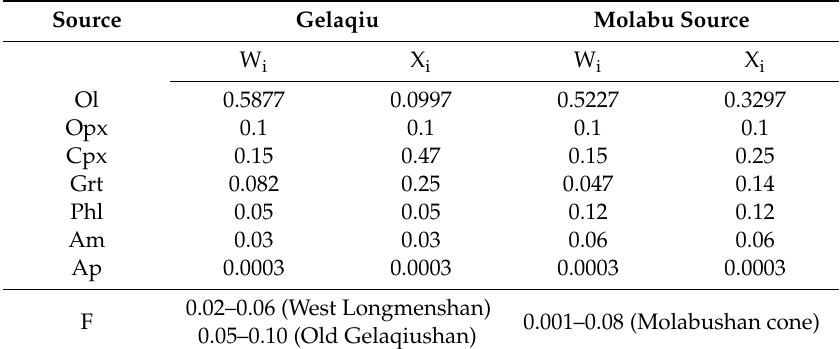
Table 3. Compositions of model sources for Wudalianchi liquids (batch partial